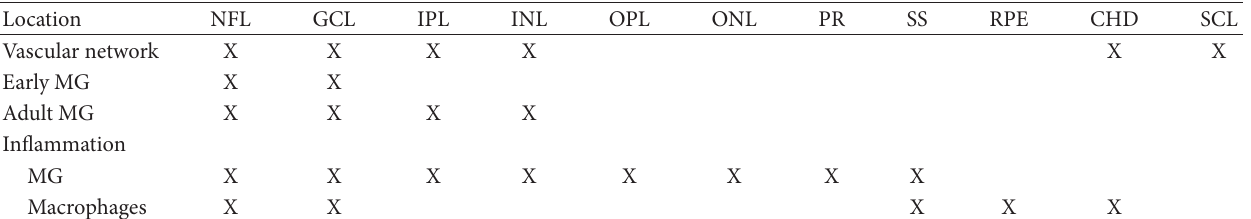
Table 1: Distribution of microglia and macrophages in retinal